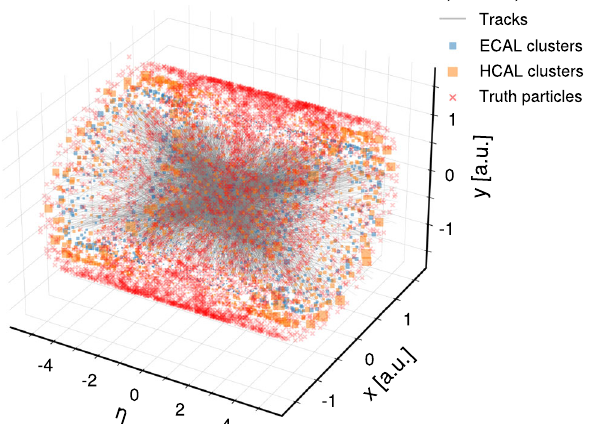
Fig. 1 A simulated tt event from the MLPF dataset with 200 PU inter- actions.Theinputtracksareshowningray,withthetrajectorycurvature being defined by the inner and outer η,φ coordinates. Electromagnetic (hadron) calorimeter clusters are shown in blue (orange), with the size corresponding to cluster energy for visualization purposes. We also show the locations of the generator particles (all types) with red cross markers. The radii and thus the x , y -coordinates of the tracker, ECAL and HCAL surfaces are arbitrary for visualization purposes